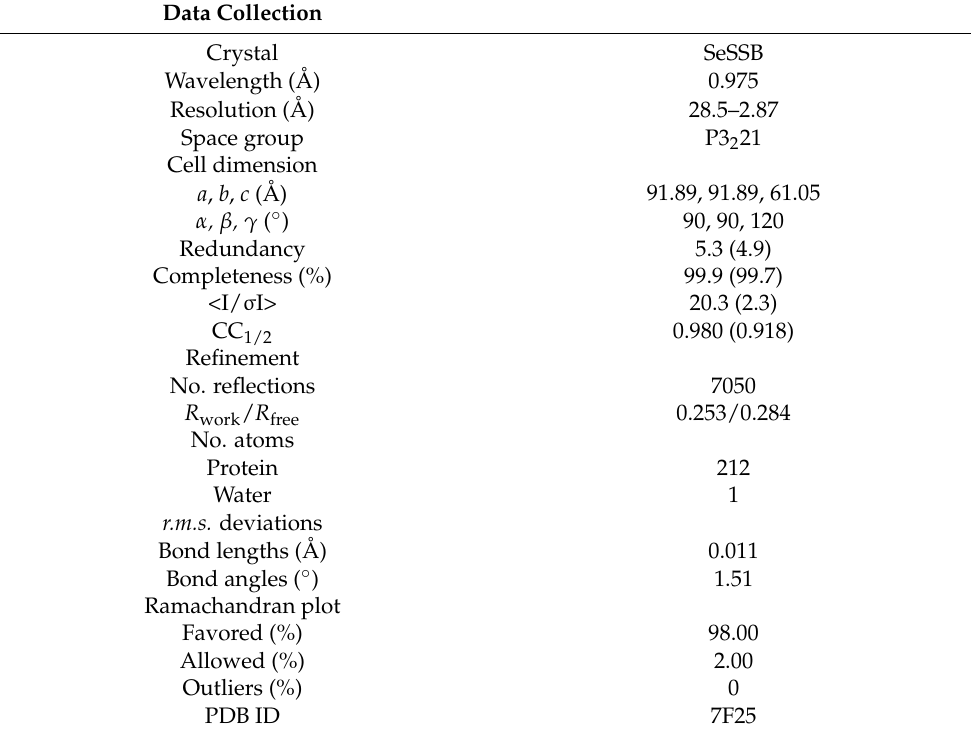
Table 1. Data collection and refinement